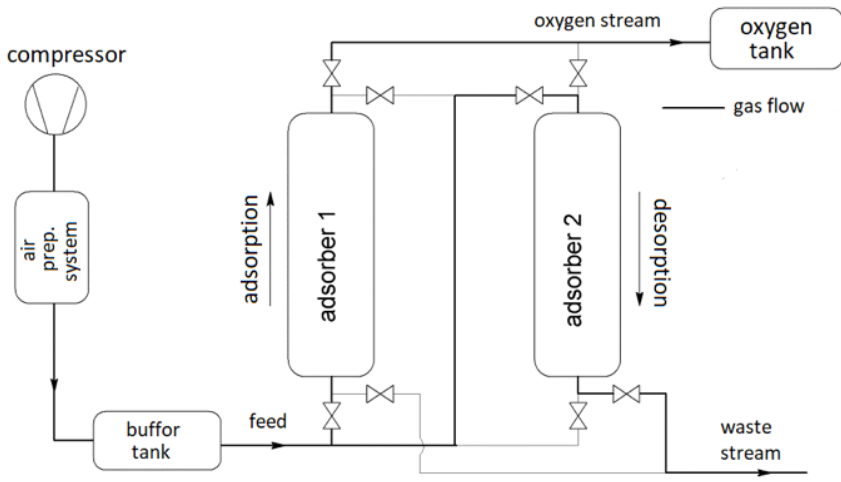
Figure 1. Scheme of an oxygen generator using the PSA method.